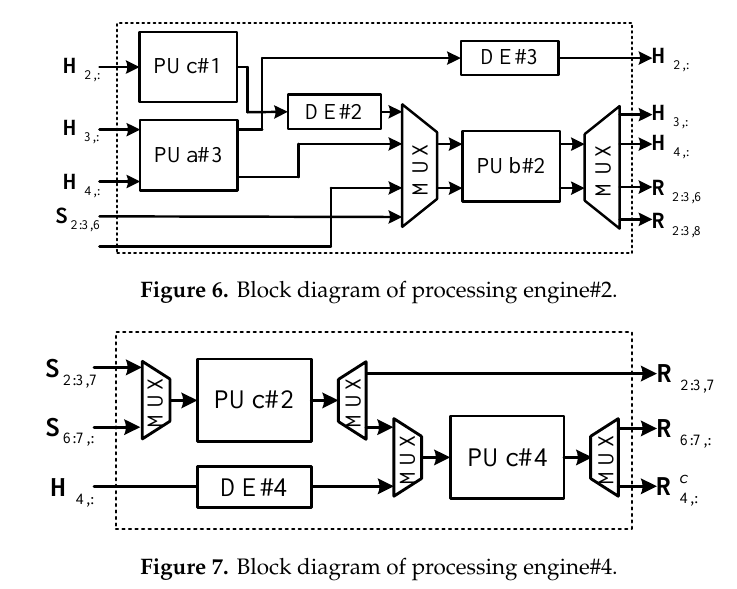
Figure 5. Block diagram of processing engines (PEs): ( a ) processing engine#1; ( b ) processing engine#3.